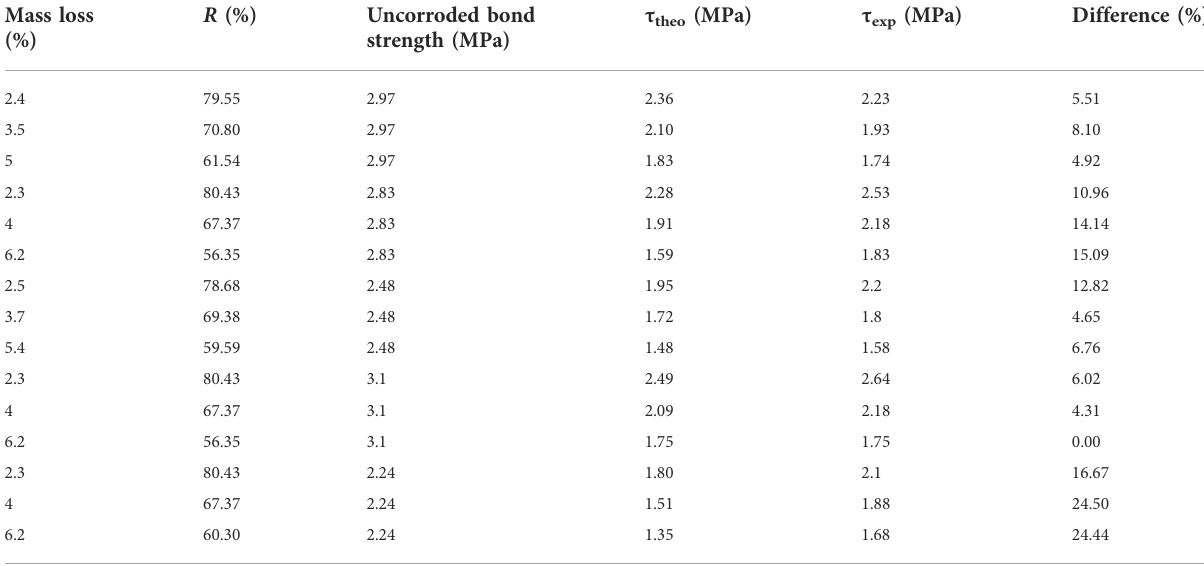
TABLE 8 Validation of the proposed model with Haddad and Al-Dalou (2018) based on steel mass loss. Mass loss (%)